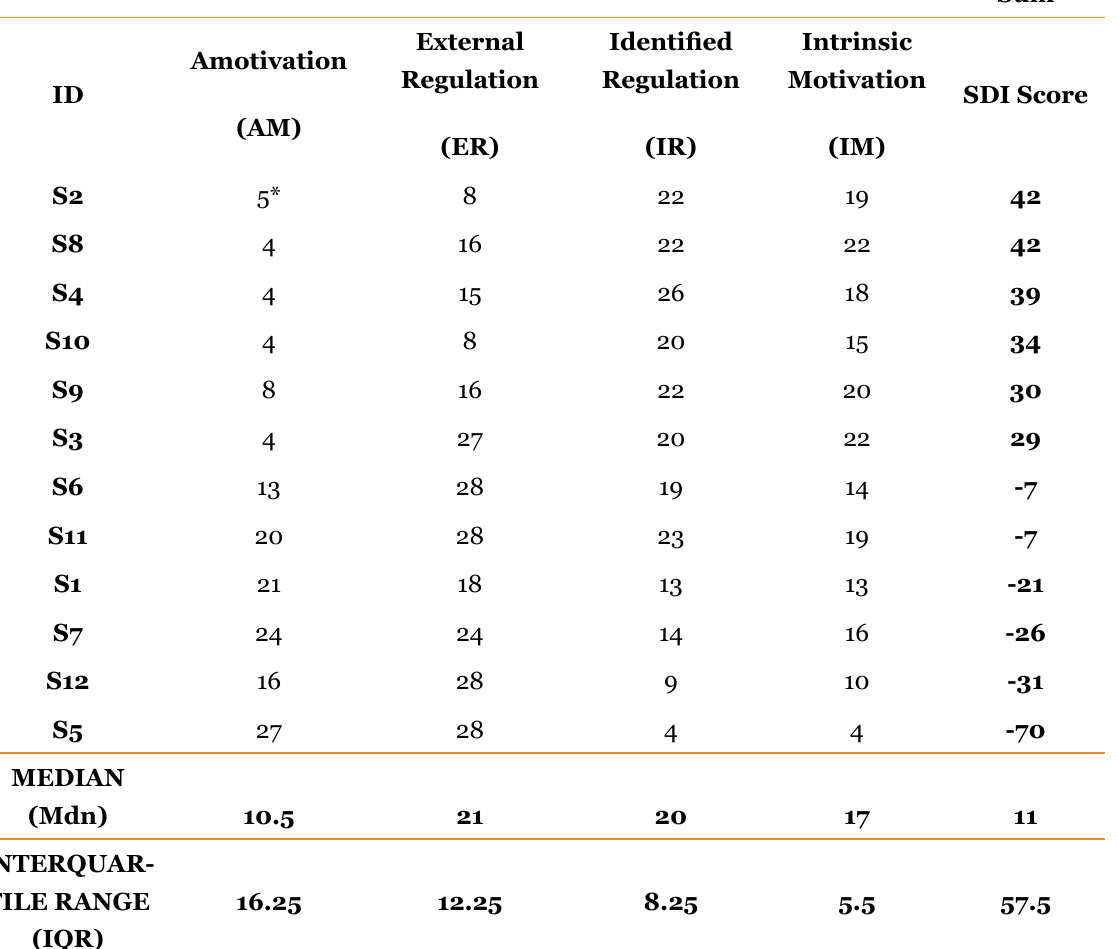
SIMS Subscale Scores